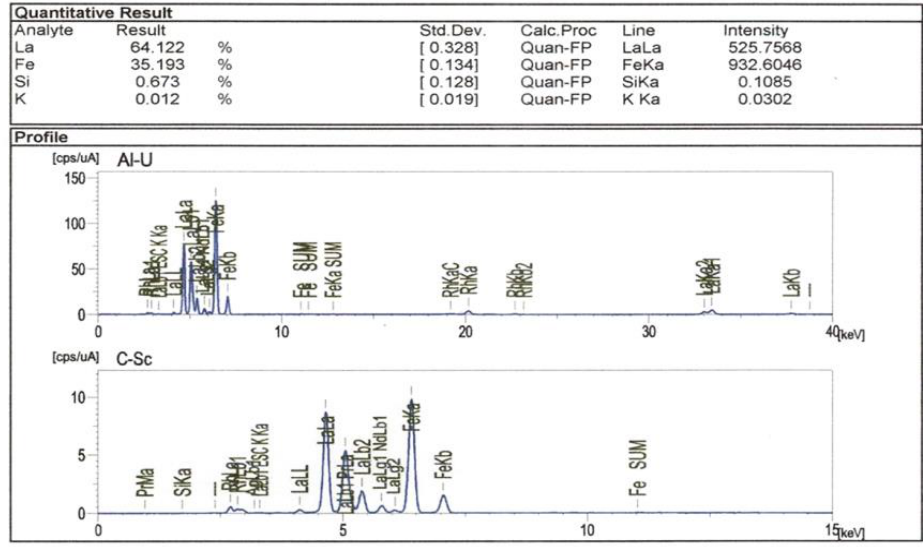
Figure 5. EDXRF spectra of LaFeO ₃ nanocrystalline particles calcined at 450